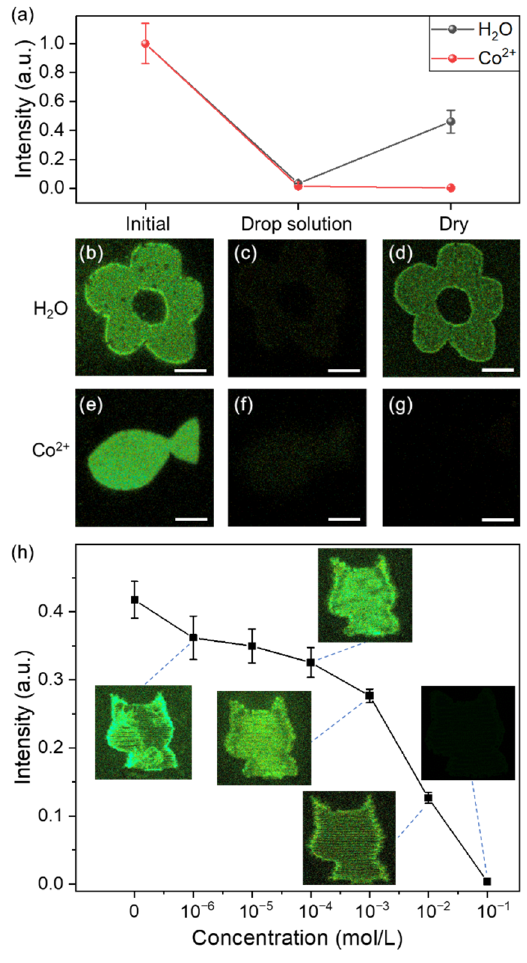
Figure 4. ( a ) Normalized fluorescence intensities of the laser-induced patterns following solvent deposition and drying. ( b ) A flower pattern fabricated using a femtosecond laser on the PVA surface, followed by 10 µ L water dropping ( c ), and consequent heating at 35 ◦ C for 2 h ( d ). ( e ) A fish pattern fabricated using a femtosecond laser on the PVA surface, followed by 10 µ L Co 2+ aqueous solution (0.1 mol/L) dropping ( f ), and consequent heating at 35 ◦ C for 2 h ( g ). ( h ) Recovered fluorescence intensity as a function of cobalt ion concentration. The insets are corresponding patterns. The intensities are normalized to the measurement of the untreated laser-patterned sample. The scale bars are 50 µ